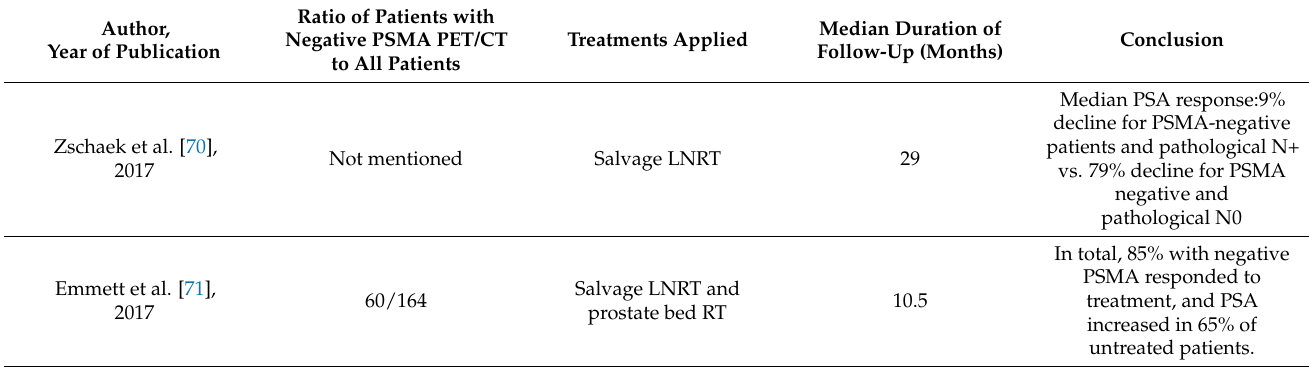
Table 2. The summary of studies reporting the treatment outcomes of patients with PSMA-negative results for prostate bed and lymph node metastasis in patients with the biochemical recurrence of prostate cancer (referred for treatment) after radical